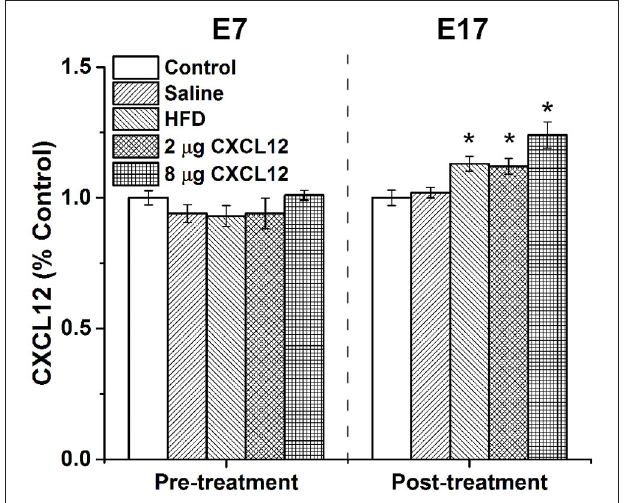
FIGURE 1 | HFD or CXCL12 exposure increases circulating CXCL12 levels in pregnant rats. Daily treatment of either a HFD or CXCL12 at 2 or 8 µ g in dams beginning at embryonic day 7 (E7) led to a significant increase in circulating CXCL12 levels by E17 as compared to control. * p < 0.05 vs. control.